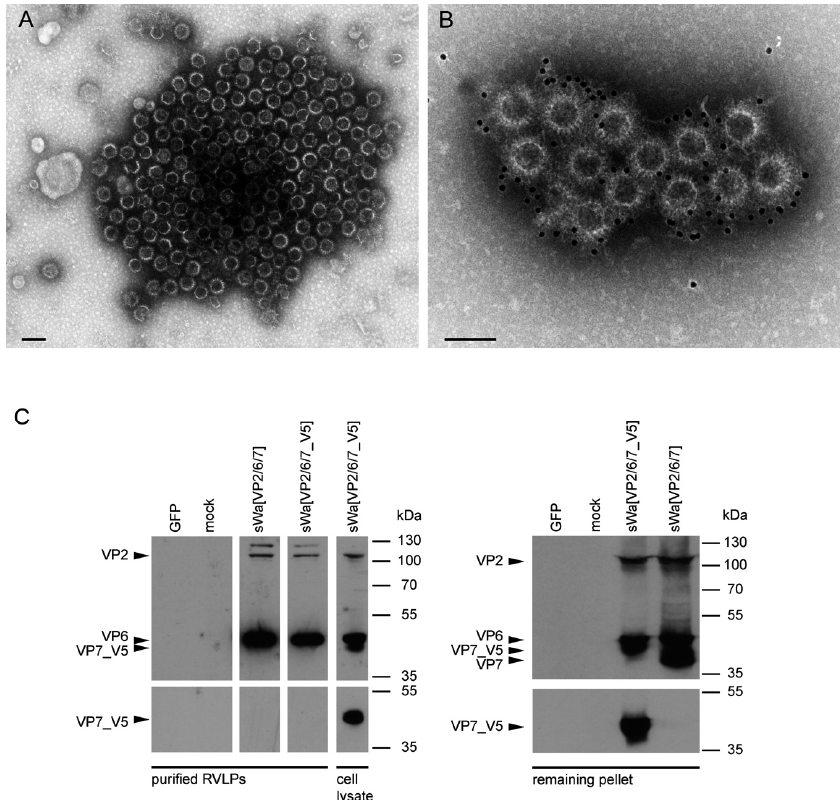
Figure 5. Analysis of rotavirus-like particles (RVLPs) produced in HSV-1 amplicon transduced cells. ( A , B ) electron micrographs of HSV-1 amplicon vector encoded RVLPs. HepG2 cells were infected with the polycistronic HSV-1 amplicon vector sWa[VP2/6/7] and two days after transduction, RVLPs were purified over a sucrose cushion and the concentrated particles were analyzed by transmission electron microscopy. ( A ) Negative staining of RVLPs from HepG2 cells transduced with sWa[VP2/6/7]. ( B ) Immunogold staining of the same sample of RVLPs as in ( A ) using a polyclonal anti-RV serum as primary antibody and a secondary antibody coupled to 12 nm colloidal gold particles. Scale bar: 100 nm ( A , B ). ( C ) Double-layered purified RVLPs and remaining RV proteins in the cell pellet. Vero2-2 cells were transduced with the indicated HSV-1 amplicon vectors (MOI 2) or non-transduced (mock). Cells were harvested 48 hpt and RVLPs were purified and concentrated from the supernatant over a sucrose cushion. The concentrated RVLPs (purified RVLPs, left panel) and the RV proteins remaining in the cell pellet obtained during RVLP harvesting (remaining pellet, right panel) was analyzed by Western blotting using a polyclonal anti-RV antibody for detection of RV proteins or the monoclonal anti-V5 antibody to detect V5 tagged VP7. In the left panel, whole cell lysate of sWa[VP2/6/7_V5] transduced (MOI 2) Vero2-2 cells was taken as positive control. The predicted migration lengths of the RV proteins are indicated on the left with an arrow and the positions of the molecular weight markers are indicated on the right in kDa.